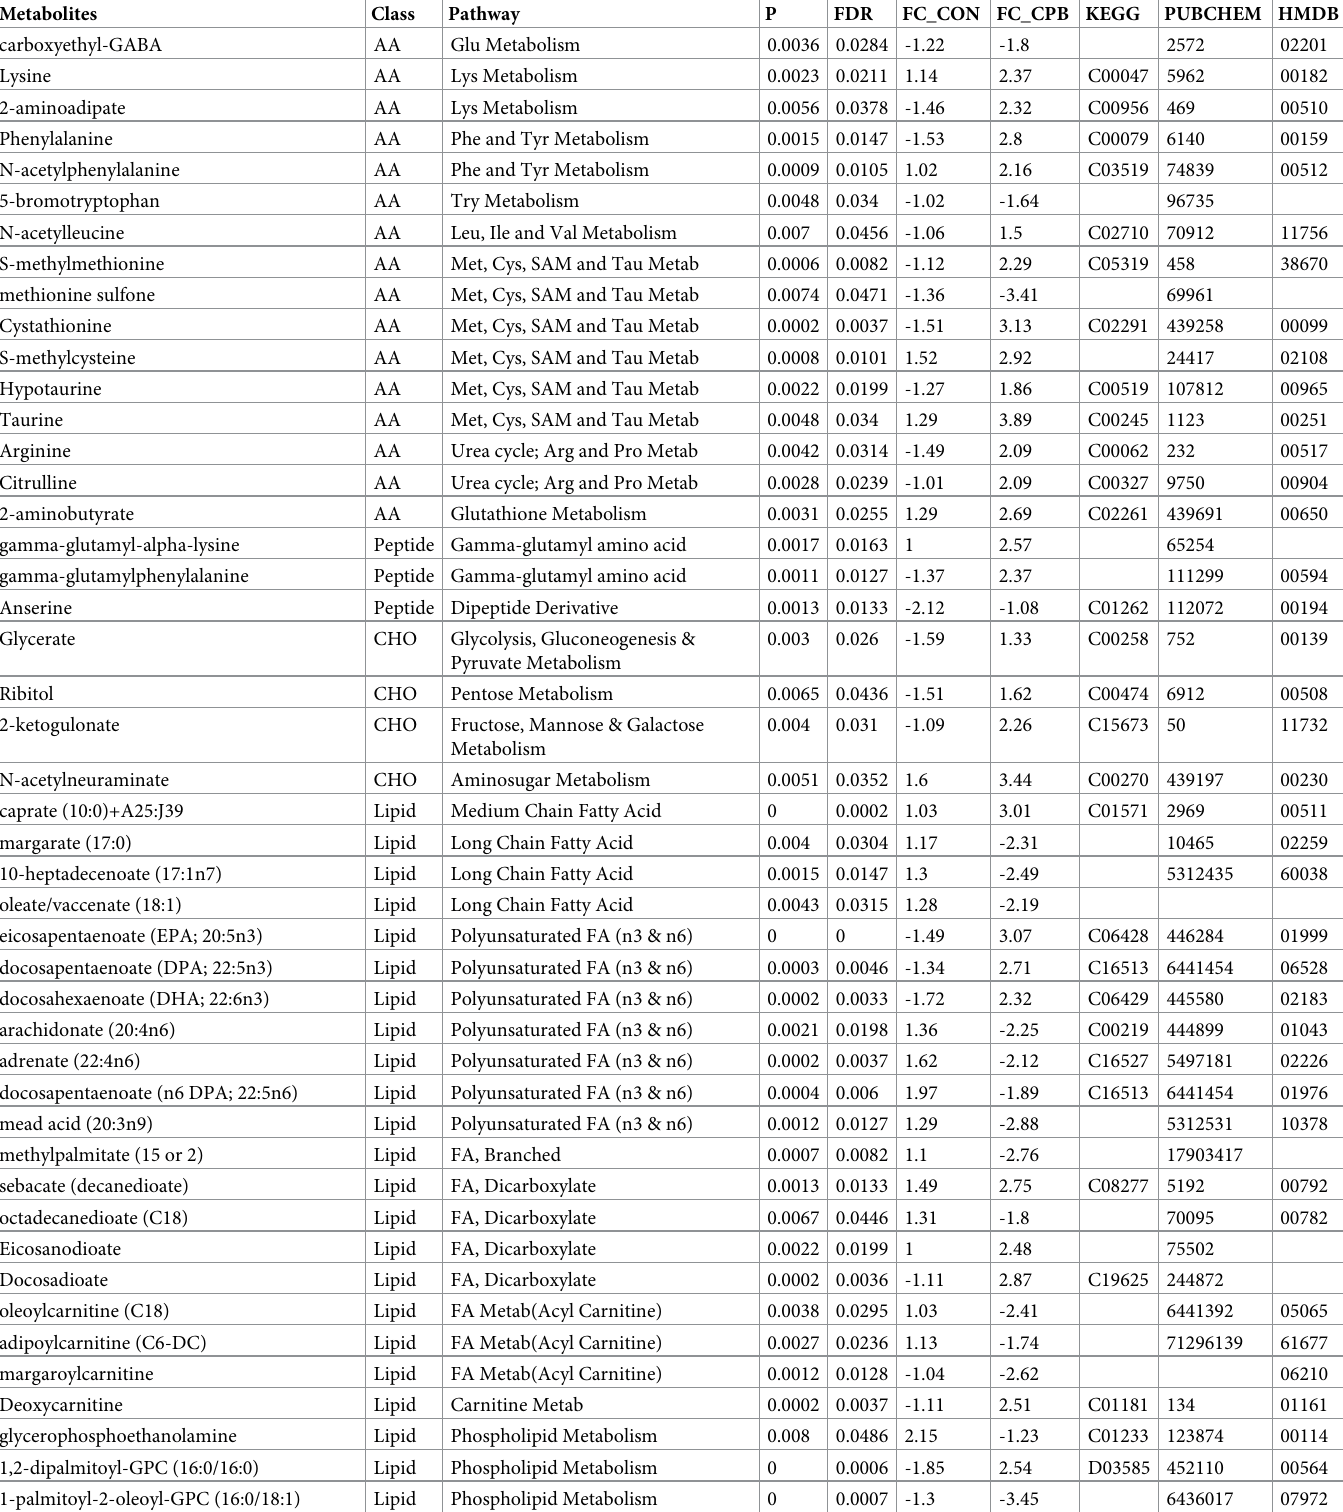
Table 1. Metabolites with significant diet by time